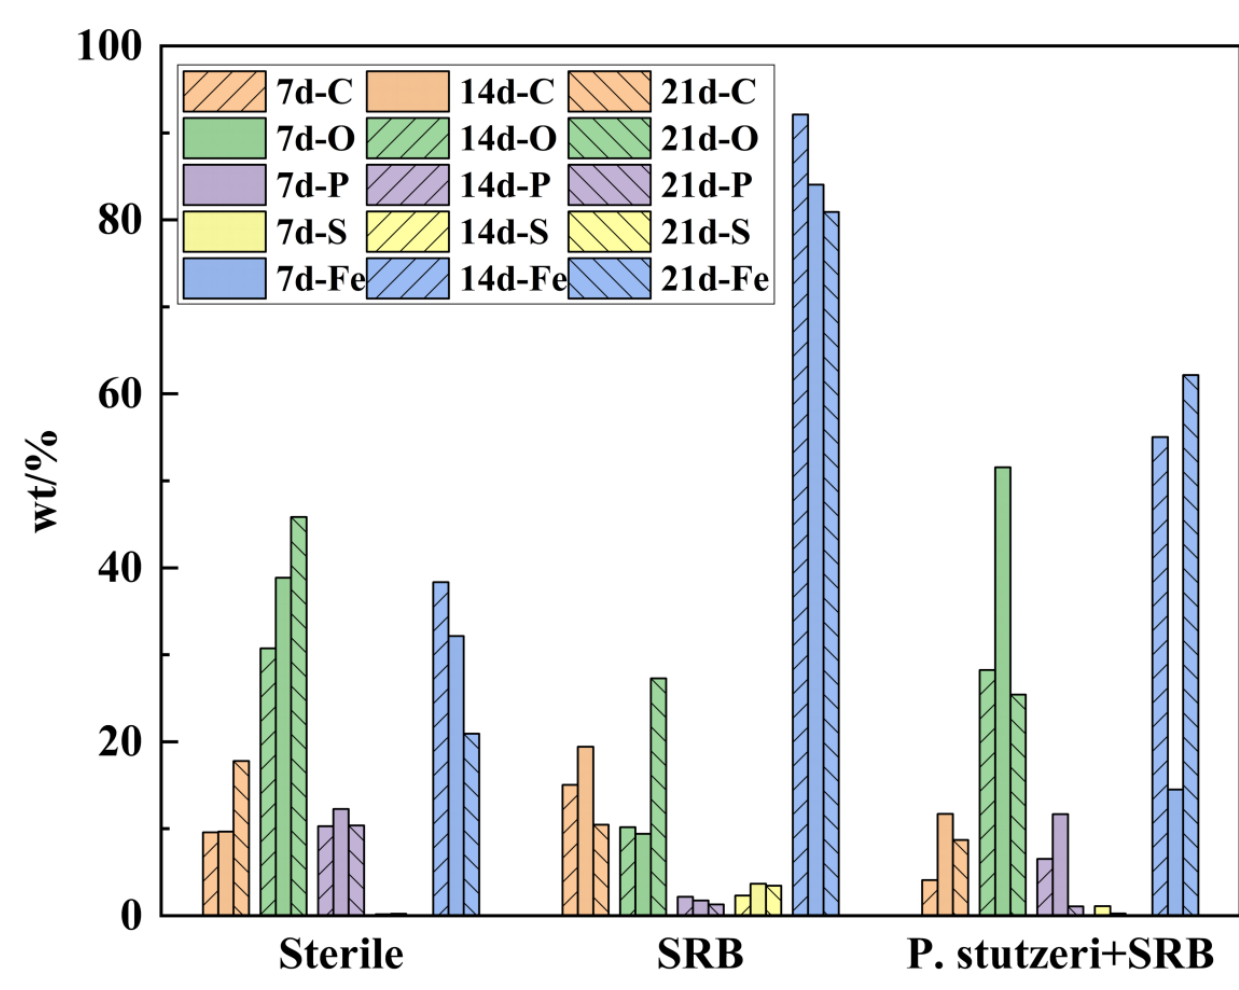
Figure 9. Element content of corrosion products on steel coupon surface.